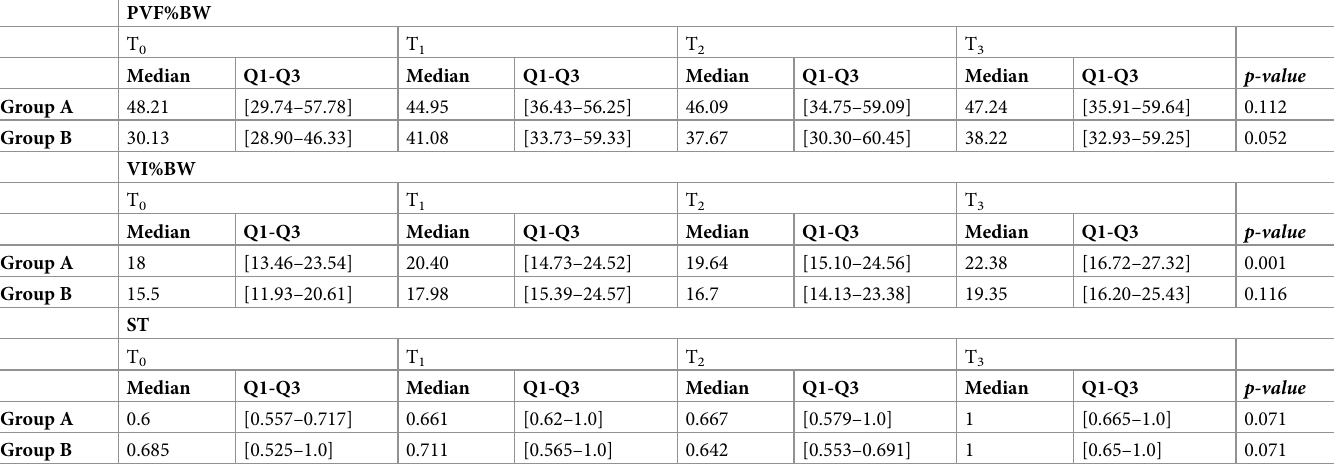
Table 5. GFRs: Quartiles for each time points and Friedmans’ ANOVA p-values.